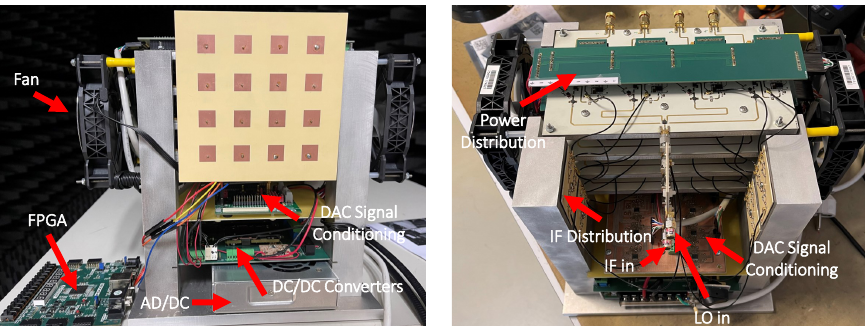
Figure 3. Full Transmitter Assembled with the several